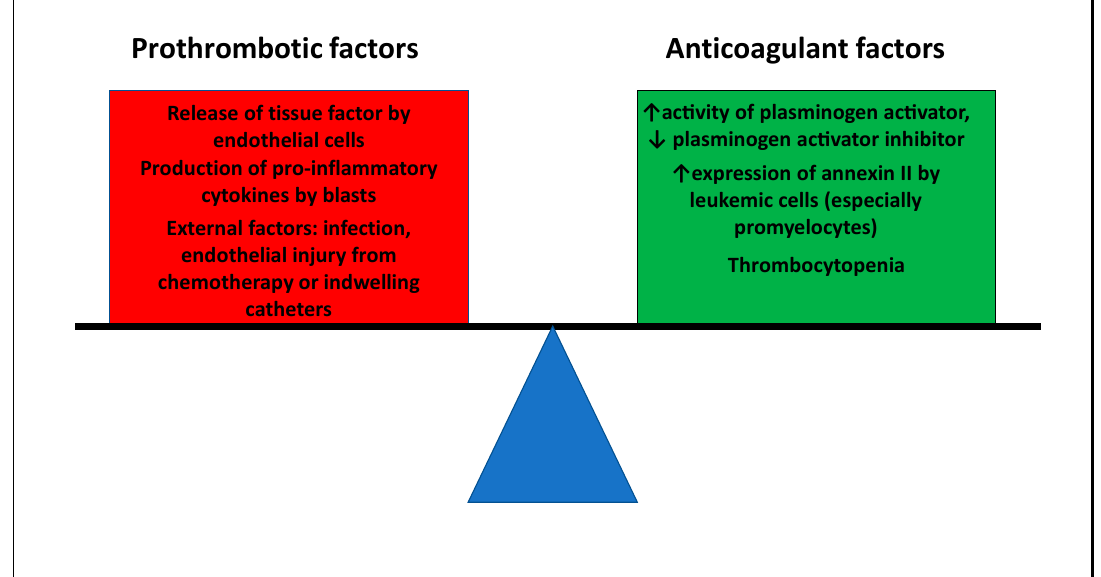
Figure 4. Pathophysiology of disseminated intravascular coagulation: DIC is characterized by an imbalance of pro- and anticoagulant factors due to both excess activation of the coagulation system and increased fibrinolysis. Prothrombotic factors in AML include the release of tissue factor from endothelial cells which is at least partly stimulated by the production of pro-inflammatory cytokines by leukemic blasts as well as external factors that promote endothelial injury such as infections, chemotherapy, or indwelling catheters. Simultaneously, anticoagulant factors contributing to the development of DIC include increased activity of plasminogen activator in conjunction with reduced levels of plasminogen activator inhibitor, increased expression of annexin II by leukemic cells, and disease-related thrombocytopenia.